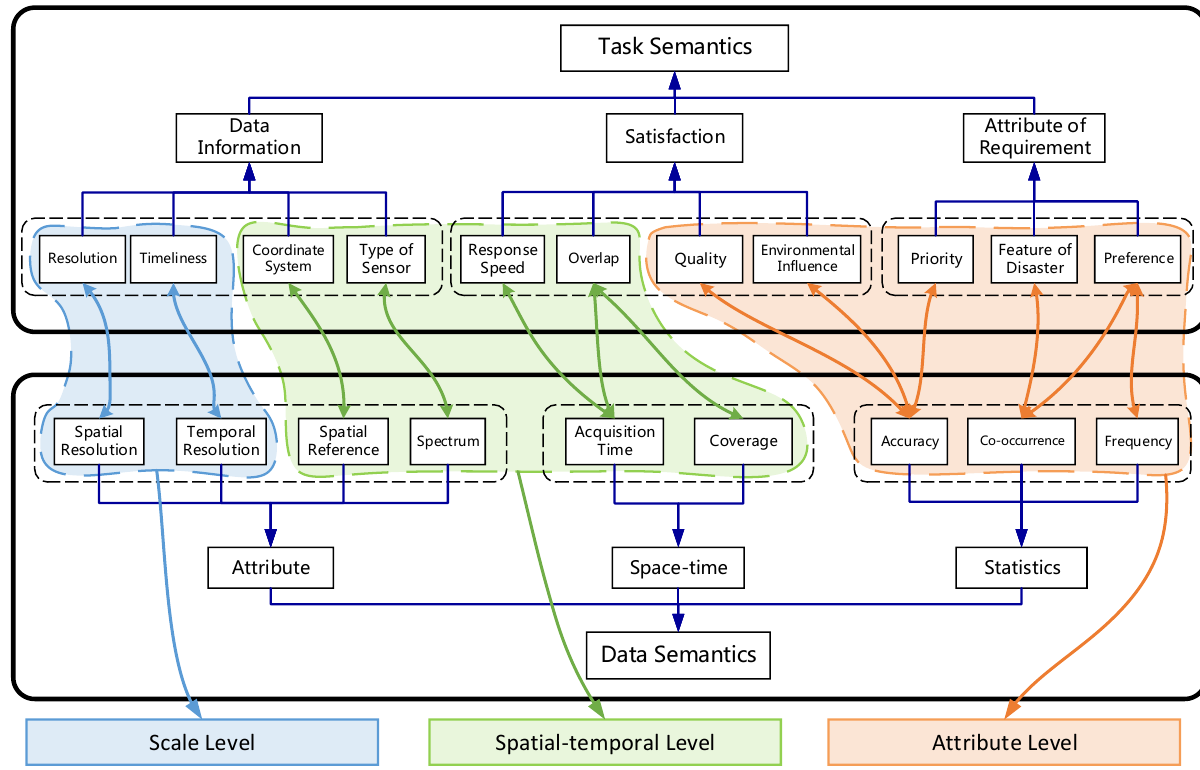
Figure 3. Semantic mapping between task and